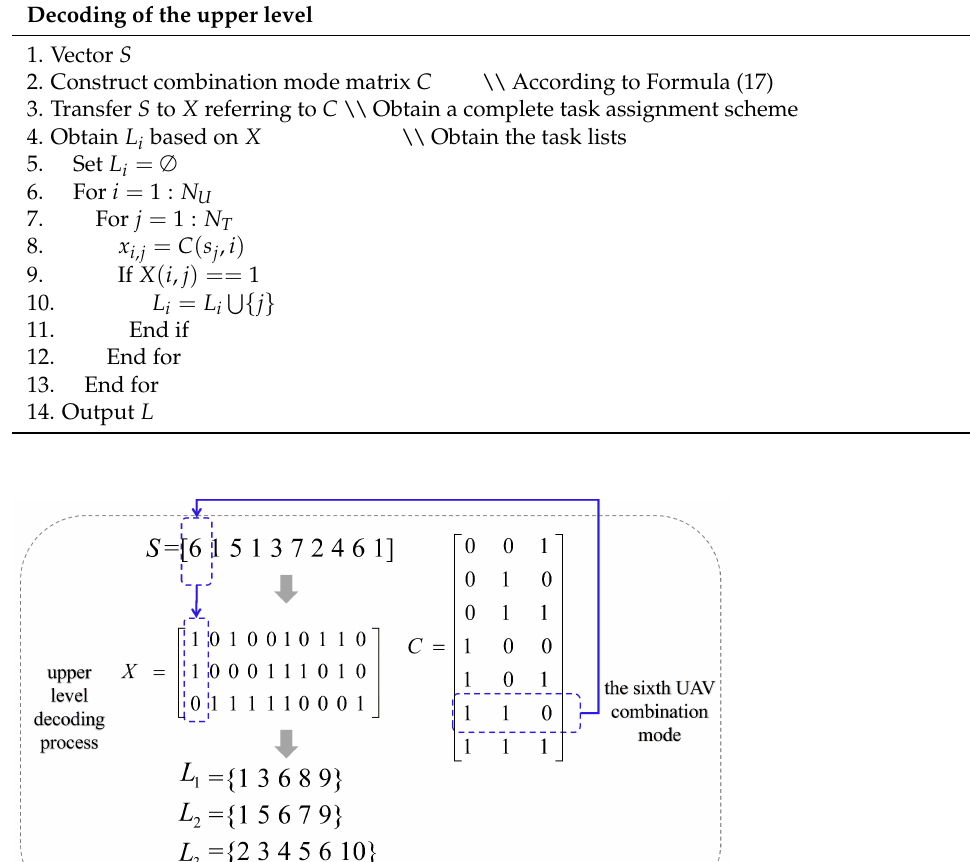
Table 2. The decoding process of the upper level.